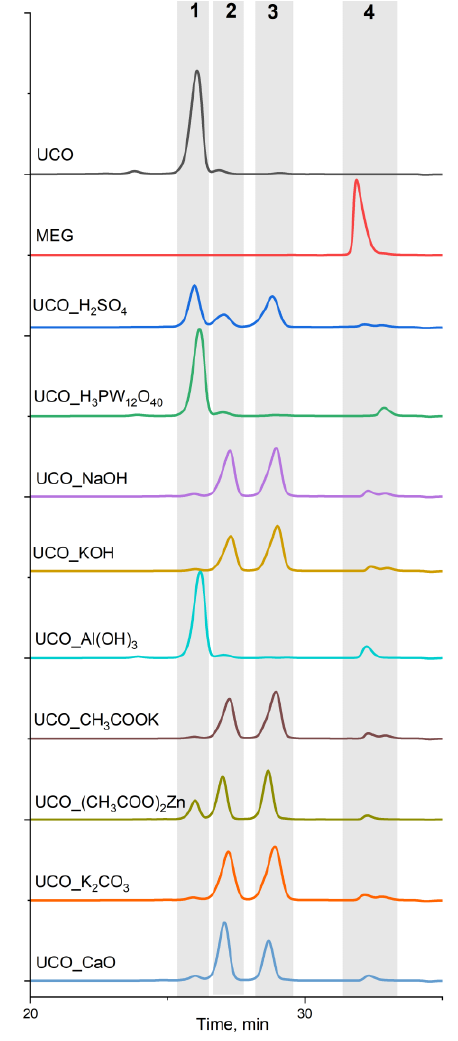
Figure 5. Chromatograms of the reaction products, 1—triglycerides, 2—diglycerides/ MEG diesters, 3—monoglycerides/ MEG monoesters, and 4—unreacted MEG and glycerol. Table 2. Effect of catalysts on the chemical compositions of bio-polyols obtained in the